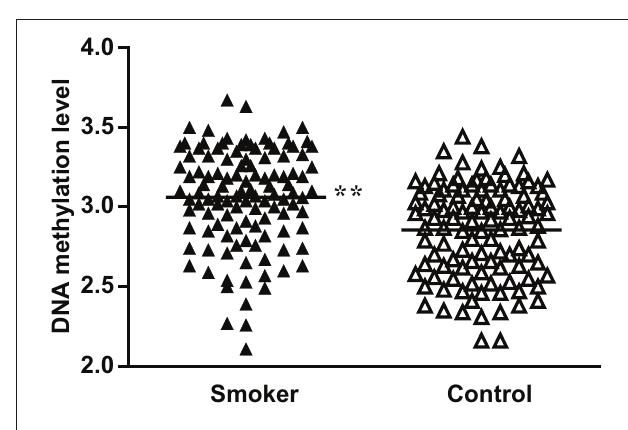
FiGure 3 | Percent methylation of the − 193 CpG site by methylation- specific PCr in MB-COMT promoter in smoker and non-smoker control samples. To meet the assumption of normality, methylation rates were logarithmic-transformed to the base e . ** P <